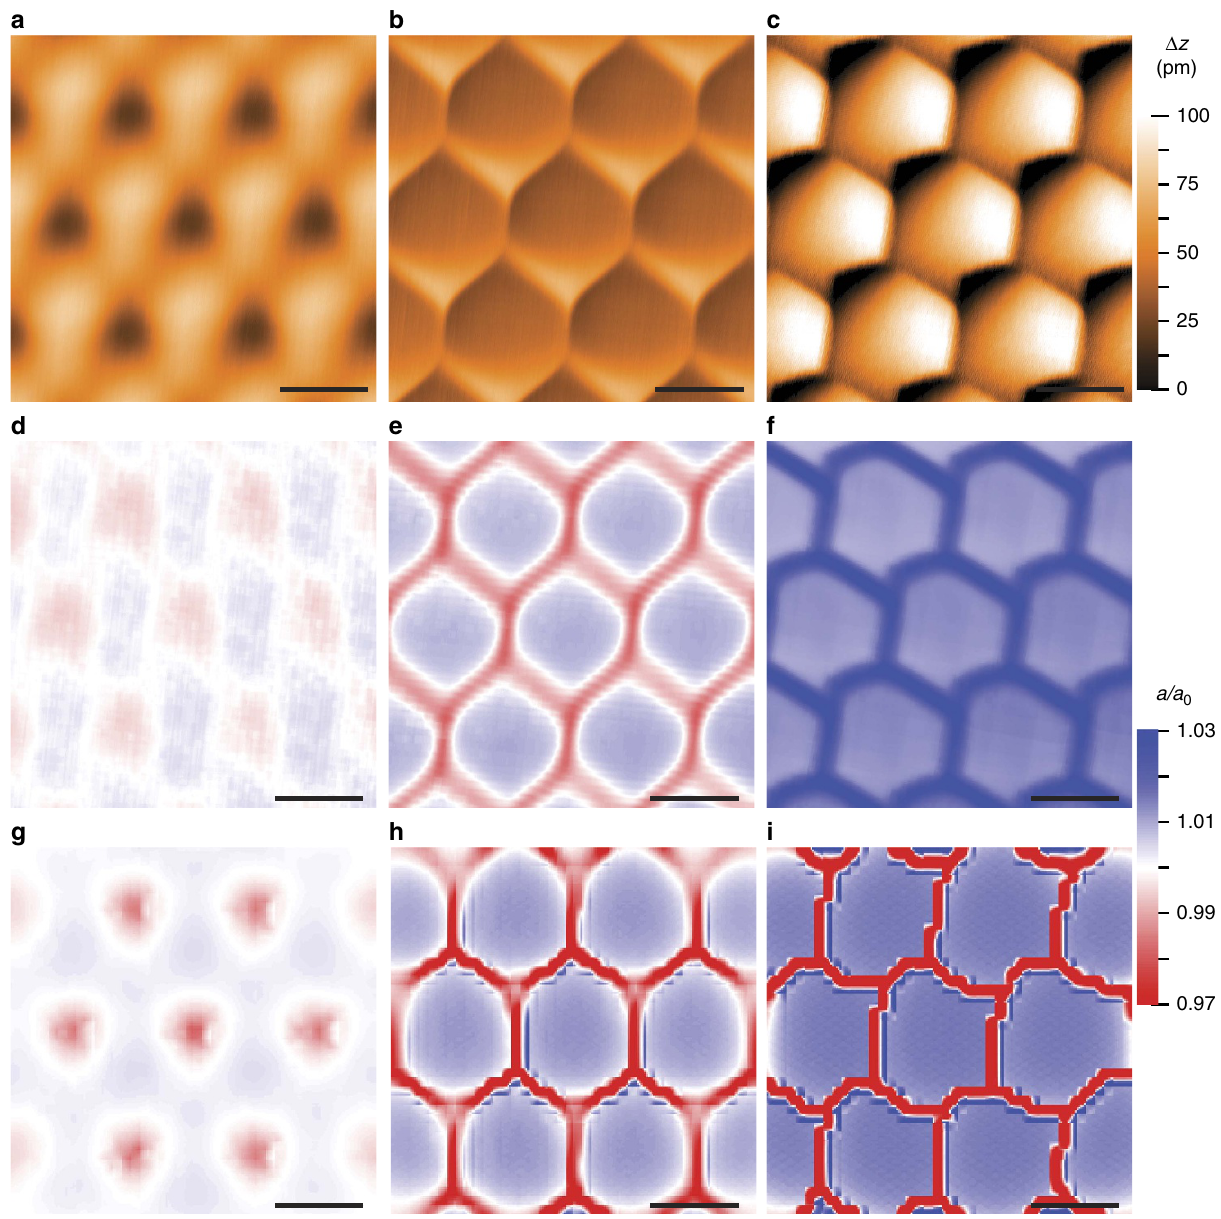
Figure 4 | Topography and strain maps in different interaction regimes. ( a – c ) Spatially-averaged topography maps acquired over the same region of a nearly-aligned sample, with the tip moving progressively closer to the sample. The appearance of the stacking boundaries becomes sharper as the tip moves closer, and becomes hysteretic and asymmetric in ( c ). ( d – f ) Experimental spatially-averaged strain maps generated from the topographic maps of ( a – c ). In ( d ) the graphene lattice is compressed in the moire´ centres and expanded along the boundaries. The opposite behaviour is observed in ( e ). In ( f ), the graphene lattice constant for the entire map is expanded, as the system is in a strongly interacting, hysteretic regime. ( g – i ) Simulated strain maps, showing excellent agreement with the experimental results. The disagreement in the dynamical strain at the stacking boundaries between ( f ) and ( i ) is attributed to the absence of out-of-plane buckling in the simulation. The tunnelling parameters are ( a ) V s ¼ 0.5V and I t ¼ 50pA, ( b ) V s ¼ 0.5V